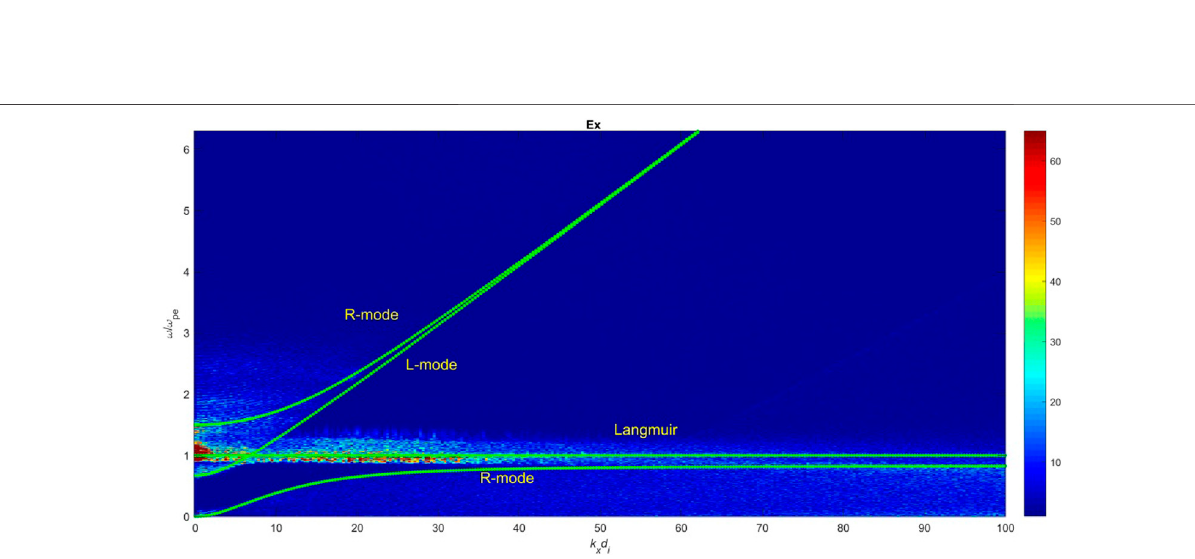
Frontiers in Astronomy and Space Sciences |